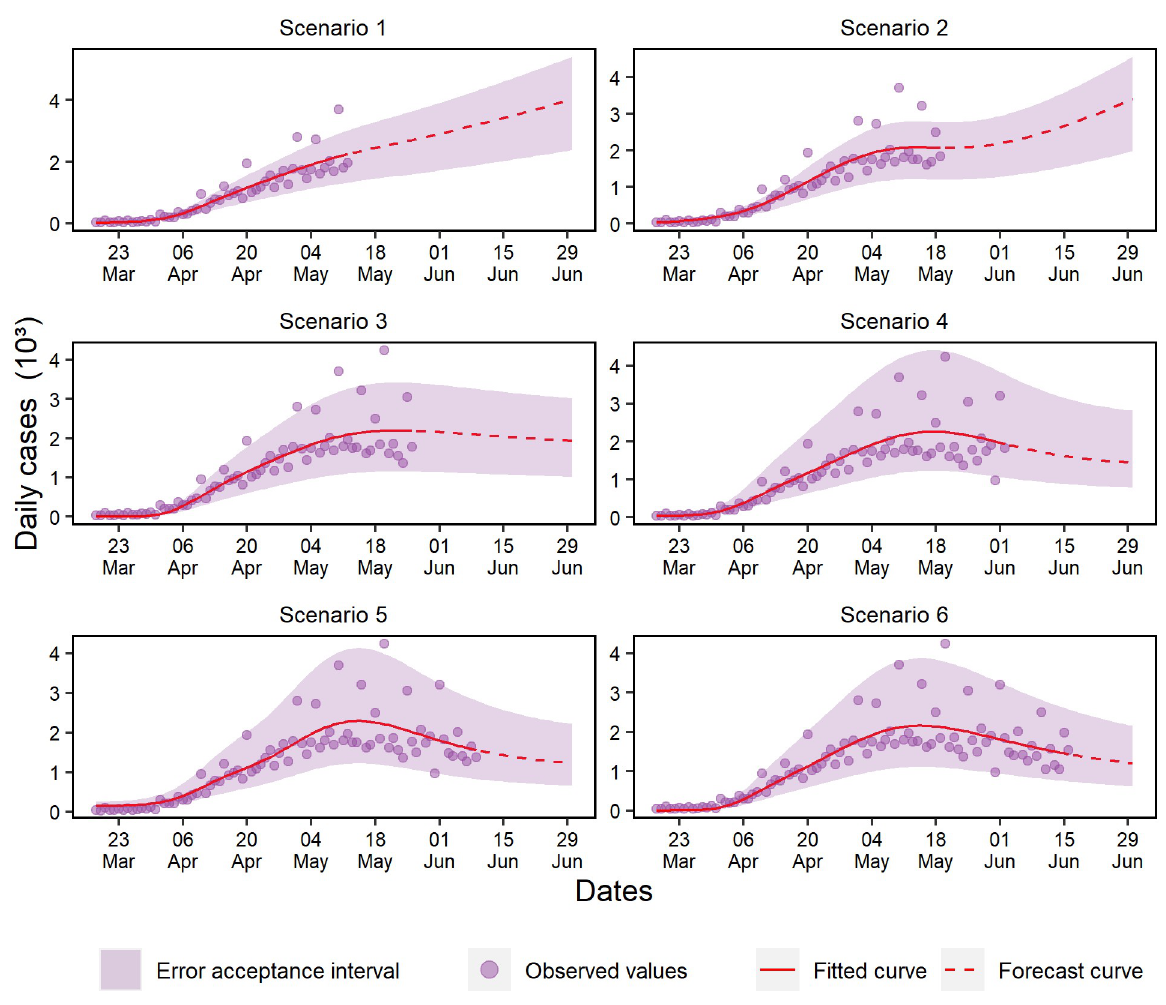
Fig 6. Forecasting of daily cases for the six analyzed